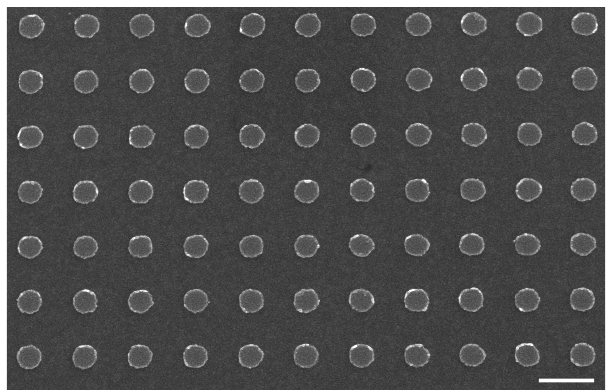
Figure 3. SEM picture of a hybrid Au/Si nanodisk array on gold film (scale bar = 300 nm). The nanodisk dimensions are 130 nm of diameter, 40 nm of total height, and 300 nm of periodicity.